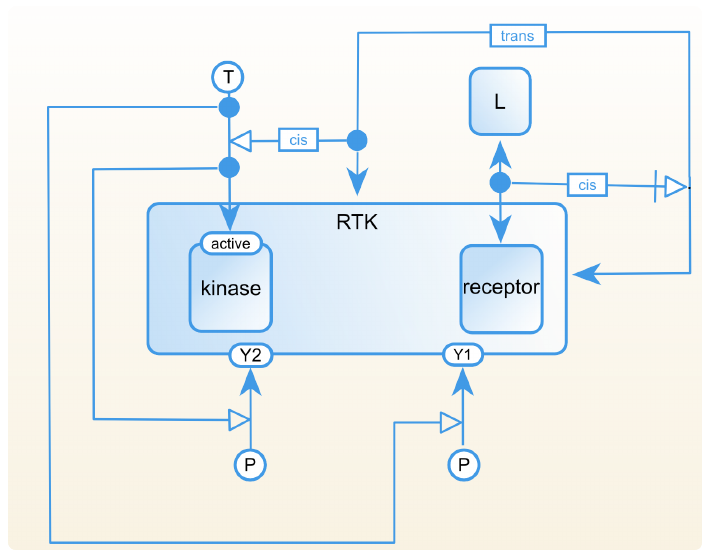
Figure A.7: The complete diagram of receptor tyrosine kinase